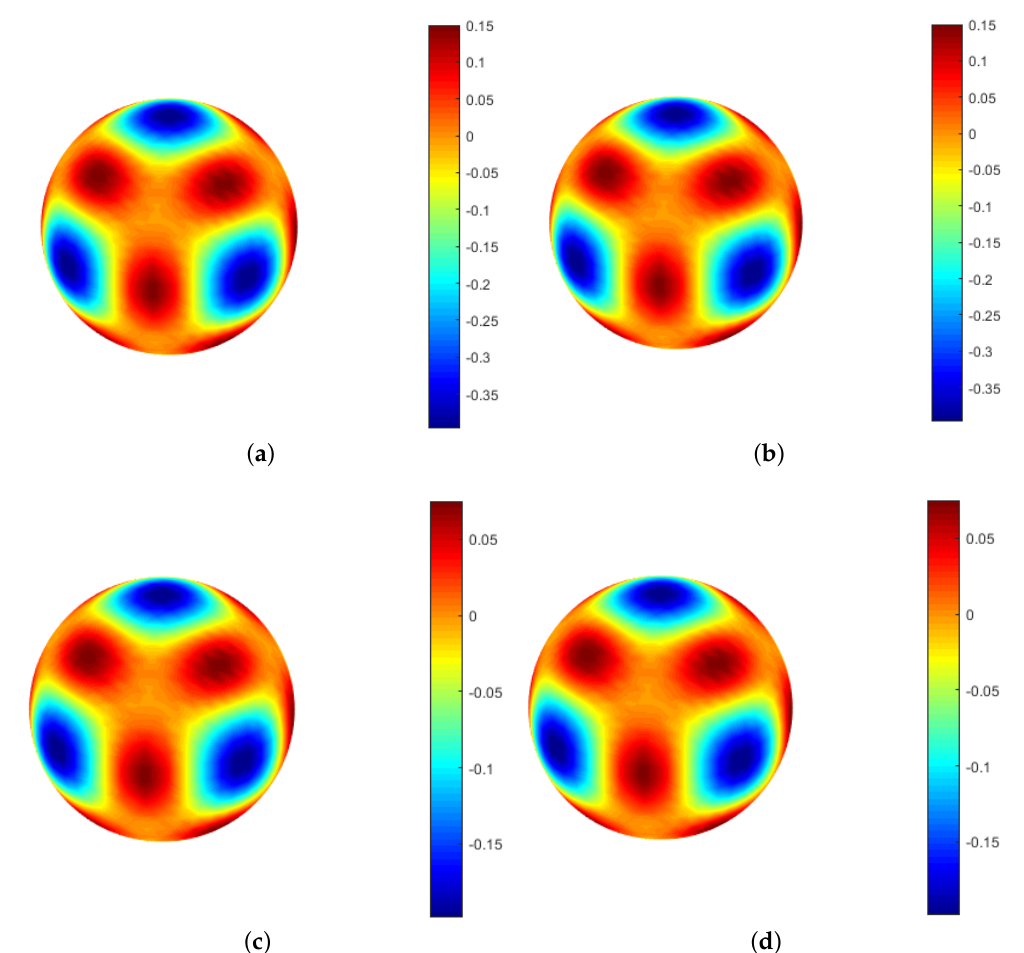
and τ = 0.5 dx 2 . 8